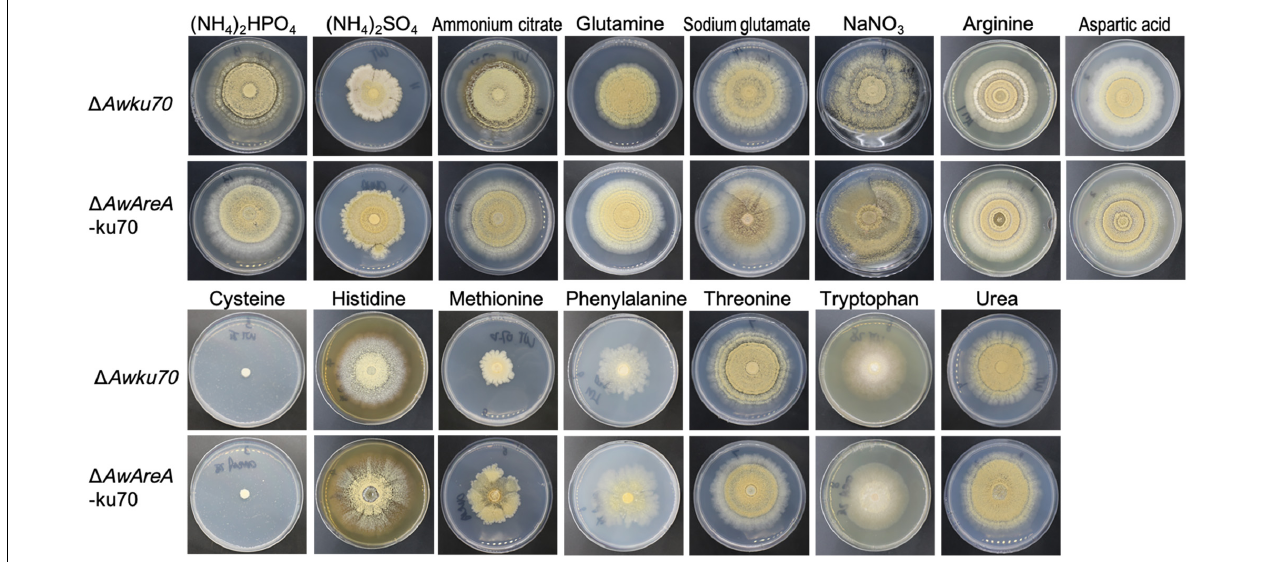
FIGURE 4 | Colony view of Aspergillus westerdijkiae (cid:49) Awku70 and (cid:49) AwAreA -ku70 grown on media containing different nitrogen sources.